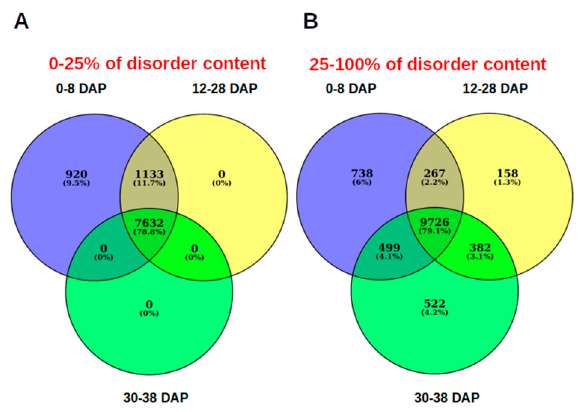
Figure 3. Venn diagrams of the shared expressed genes (TPM -Transcripts Per Kilobase Million- > 0) of each stage, according to the disordered content of the proteins codified by each transcript. ( A ) Transcripts encoding for structured proteins (0–25% of disorder content) is expressed in the early (0–8 Days After Pollination -DAP-) and then are turned o ff in the following stages. ( B ) There are transcripts encoding for intrinsically disordered proteins (IDPs) which are expressed specifically in each stage.